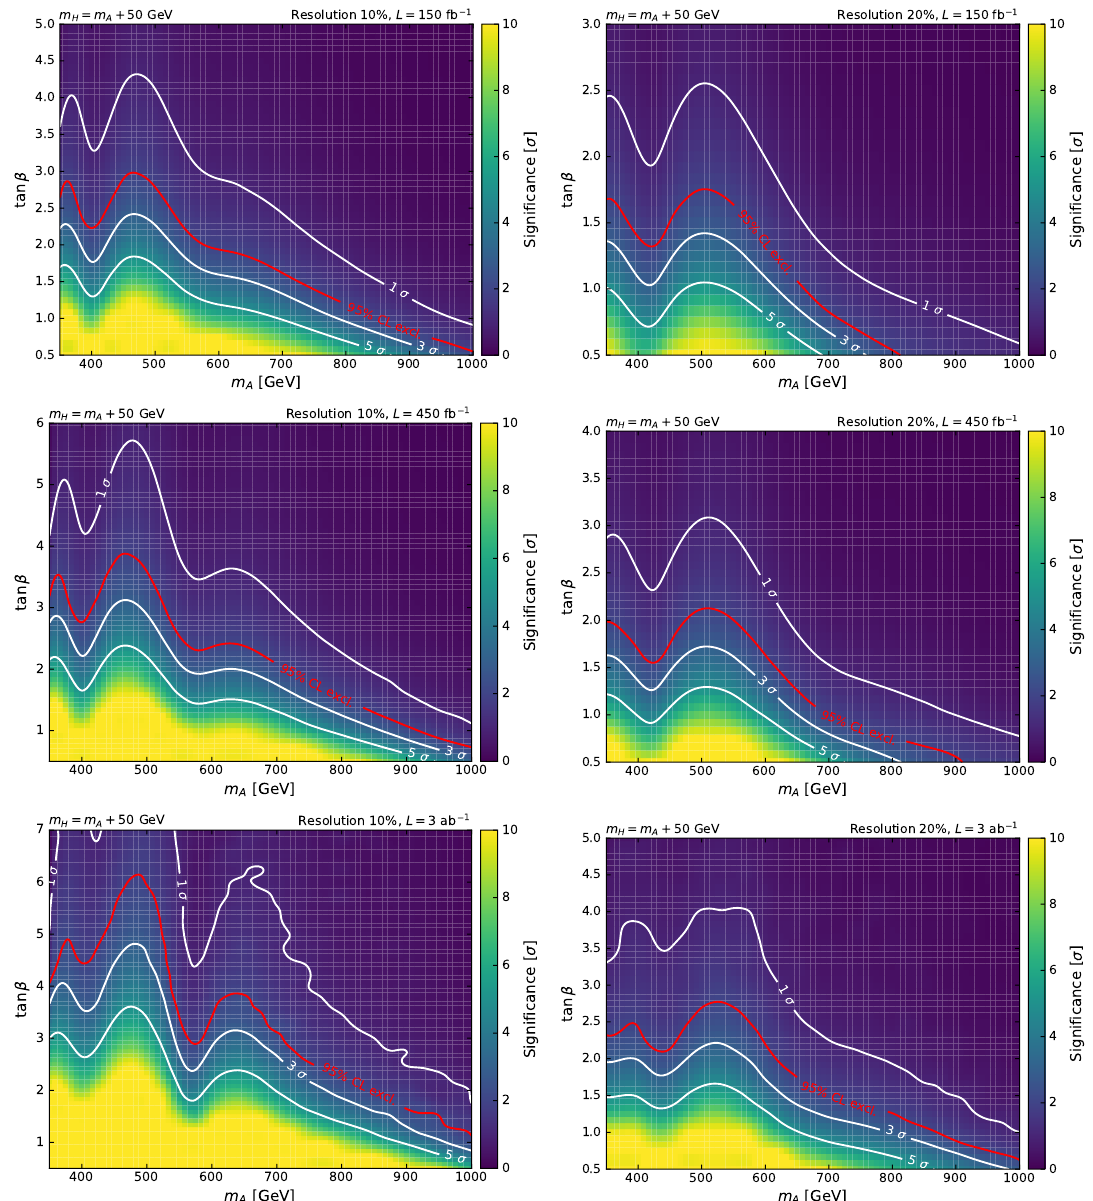
Figure 13 . Expected signi(cid:12)cance and exclusion potential for a Type II 2HDM with a mass splitting M H (cid:0) M A = 50 GeV in the same six experimental scenarios as considered in (cid:12)gure 10. Values of signi(cid:12)cance in excess of 10 (cid:27) are clipped. A resolution of 10% and 20% is assumed for the left- and the right-hand side plots,